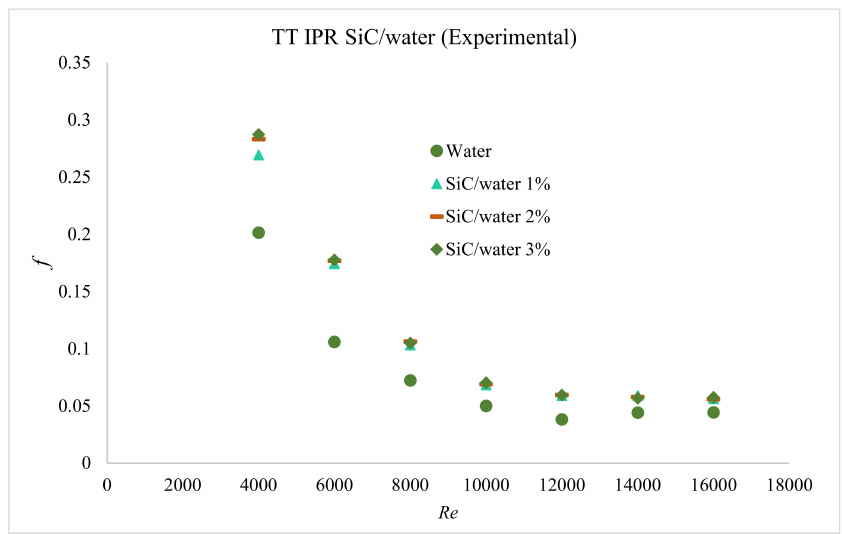
Figure 26. E ff ect of the nanofluid volume fraction ϕ on f. (Numerical).